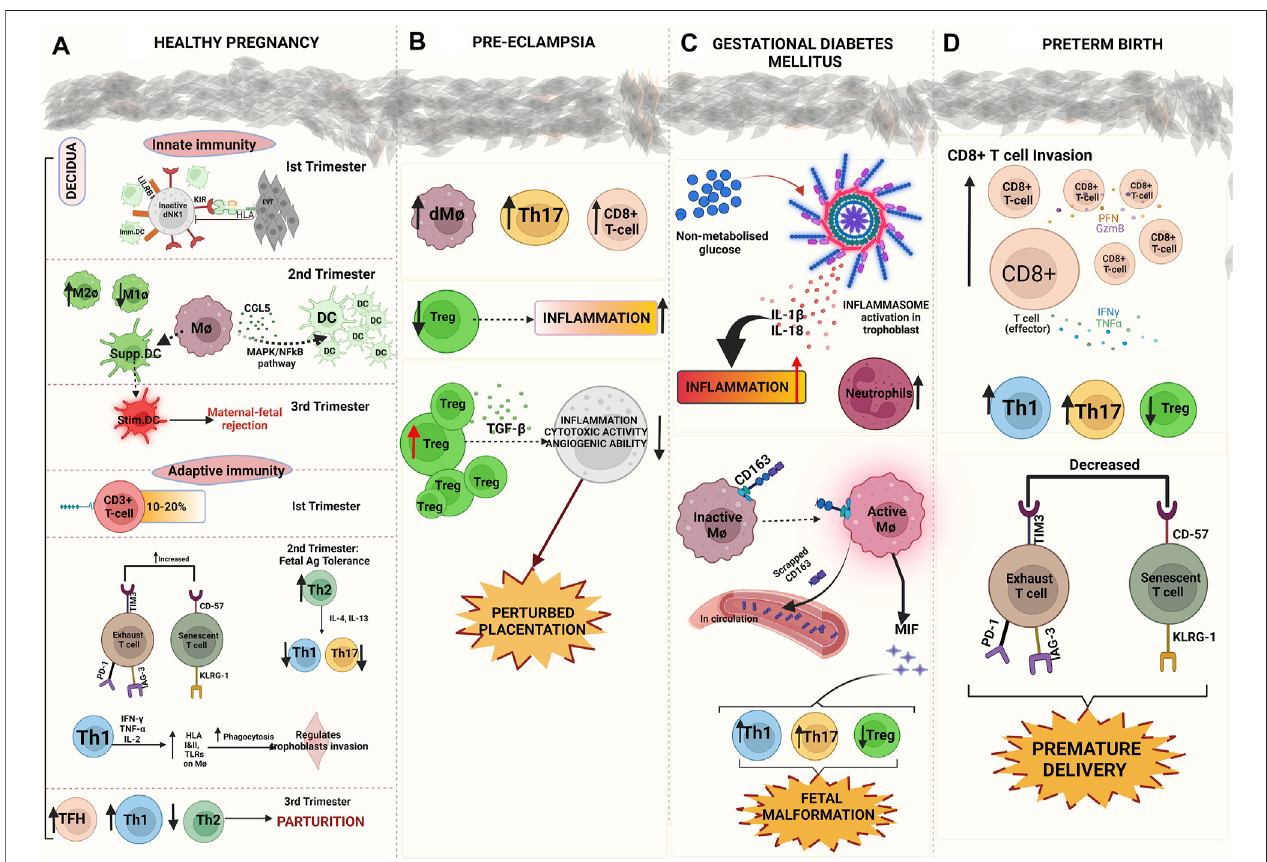
FIGURE 2 | Immununological changes in pregnancy across gestation and in complications. (A) Healthy pregnancy: Innate immune responses: HLA disparity on extravillous trophoblasts (EVTs) causes NK suppression ( fi rst Trimester), increased M2Ø expression, production of DCs recruiting chemokine CCL5, accumulation of immature immunosuppressive DCs in decidua (second Trimester) for progression of pregnancy, differentiation of immunosuppressive DCs into stimulatory DCs contributing to parturition (third Trimester). Adaptive immune responses: 10 – 20% CD3 + Tcells exists in fi rst Trimester, increased exhausted and senescent T cell population, increased Th2, decreased Th1 and Th17, pro-in fl ammatory cytokines (IFN- γ , TNF- α , IL-2) stimulate MØ to regulate trophoblasts invasion by phagocytosis (second Trimester), Increased expression of Th1, TFh, and decreased expression of Th2 promotes parturition as the gestation ends (third Trimester) (B) Immune dysregulationinpre-eclampsia(PE)-IncreasedexpressionofdecidualMØ,Thelper17cells,CD8 + cytotoxicTcells,increasedsuppressionofregulatoryTcells(Tregs)all these events lead to in fl ammation. Hyper-activation of Tregs causes decreased cytotoxic and angiogenic responses from NK cells leading to perturbed placentation causingPE (C) GestationalDiabetesmellitus(GDM)Increasedlevelsofnon-metabolizedglucoseinducesin fl ammasomeactivationcausingcytokinestorm(IL-1 β ,IL-18) and increased neutrophilia leading to hyper-in fl ammation (MØ) activation causes cleavage of CD163 surface marker and its release into circulation, MØ releases MØ migration inhibitory factor (MIF) that further stimulates Th1 and Th17 promoting in fl ammation in GDM pathogenesis (D) Preterm birth (PTB) Increased CD8 + cytotoxic Tcellsin fi ltratethedecidua, increasedTh1, Th17,anddecreasedTregexpression promotein fl ammation.Decreasedexpressionofexhaustedand senescent Tcellsare involved in PTB pathogenesis.